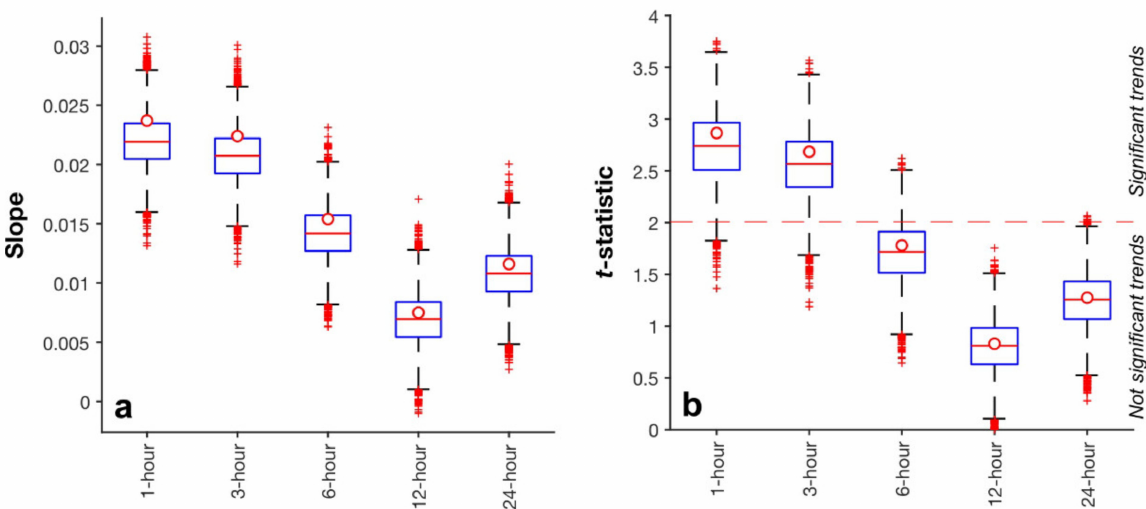
Figure 15. Boxplots showing the results obtained from trend analysis of the annual maximum rainfall time series filled with synthetic data. ( a ) Distributions of the trend slope values b fill ( σ /year). Red circles represent the slope values found for the standardized time series with data gaps. ( b ) Distributions of the test statistic t fill (red dashed line indicate the critical value of the t -test, which is t c = 2.005). Red circles represent the t -test values found for the standardized time series with data